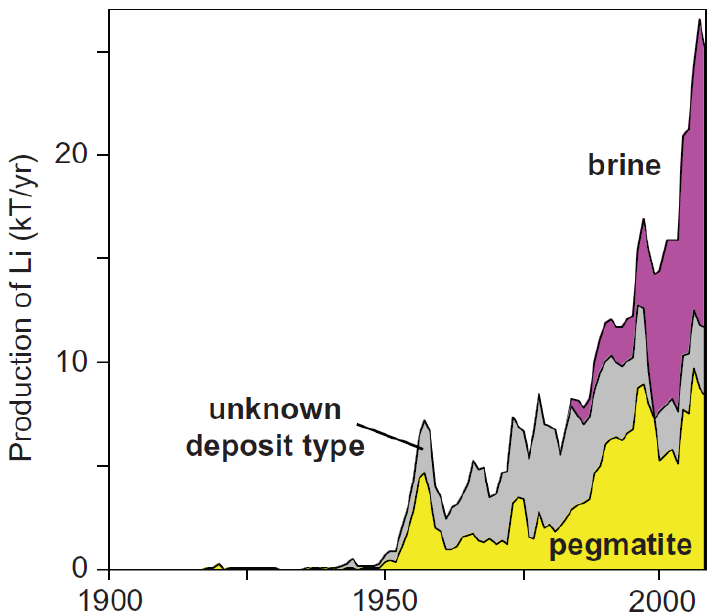
Figure 2. Lithium production since 1900 [9]. Lithium is found in three main deposit types: pegmatites, continental brines, and hydrothermally altered clays. Lithium mining increased exponentially starting in the 1950s due to its use as a component in modern materials, including in metal alloys, specialty glass, and ceramics. Reproduced with permission of the Society of Economic Geologists, Inc. Economic Geology, v. 18, 339 – 365.